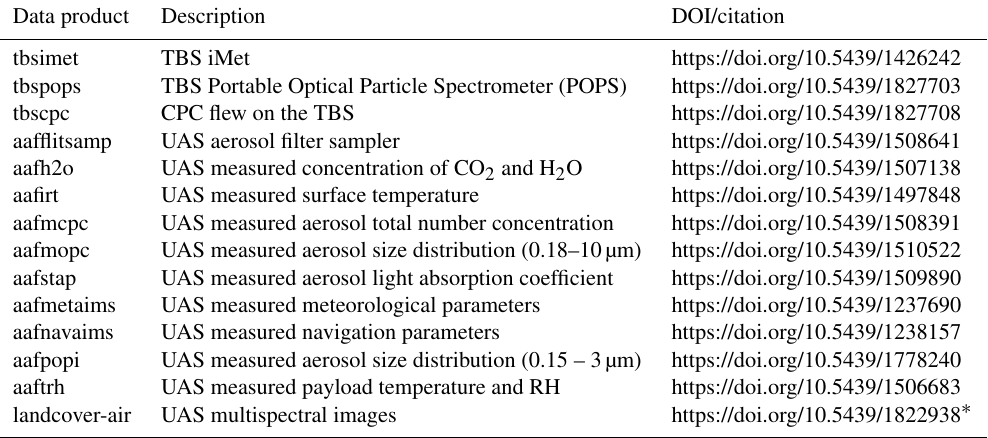
Table 3. DOI for main TBS/UAS datasets. The overall DOI for the data archived in 2021 is https://doi.org/10.5439/1846798 (Mei and Dexheimer,